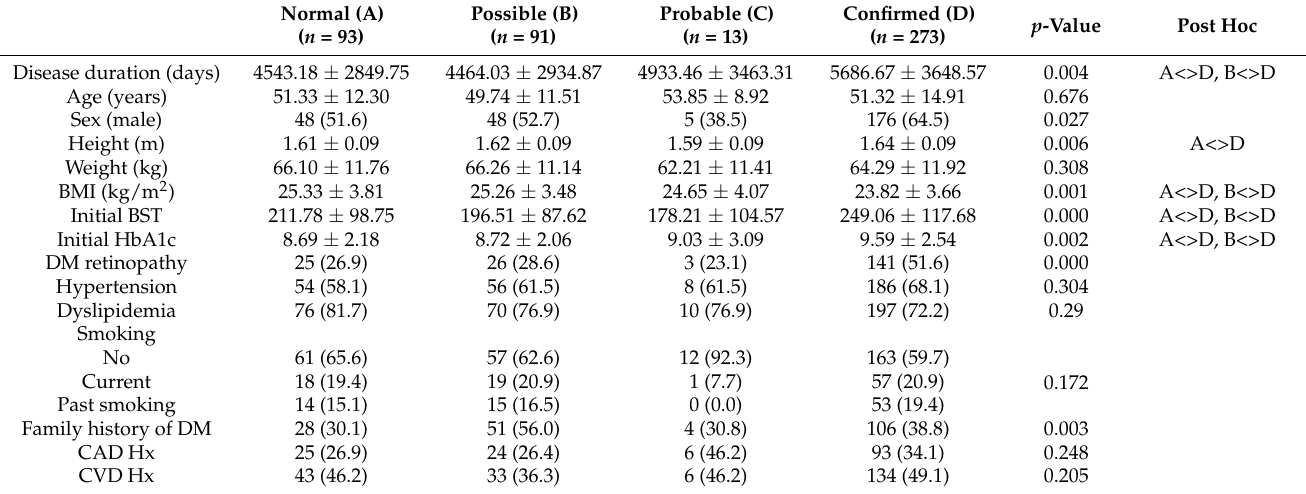
Table 2. Baseline characteristics of